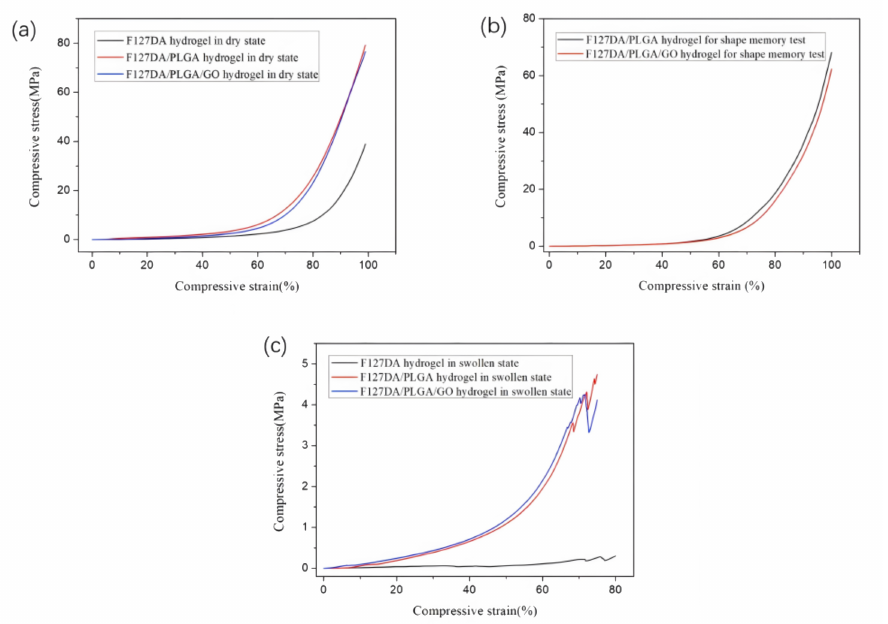
Figure 16. ( a ) Compressive stress − strain curves of F127DA, F127DA/PLGA, and F127DA/PLGA/GO hydrogels in a dried state at room temperature. ( b ) Compressive stress − strain curves of F127DA, F127DA/PLGA, and F127DA/PLGA/GO hydrogels for shape-memory test at room temperature. ( c ) Compressive stress − strain curves of F127DA, F127DA/PLGA, and F127DA/PLGA/GO hydrogels in swollen state at room temperature. Reprinted with permission from Ref. [132]. Copyright 2019, Dai, W.